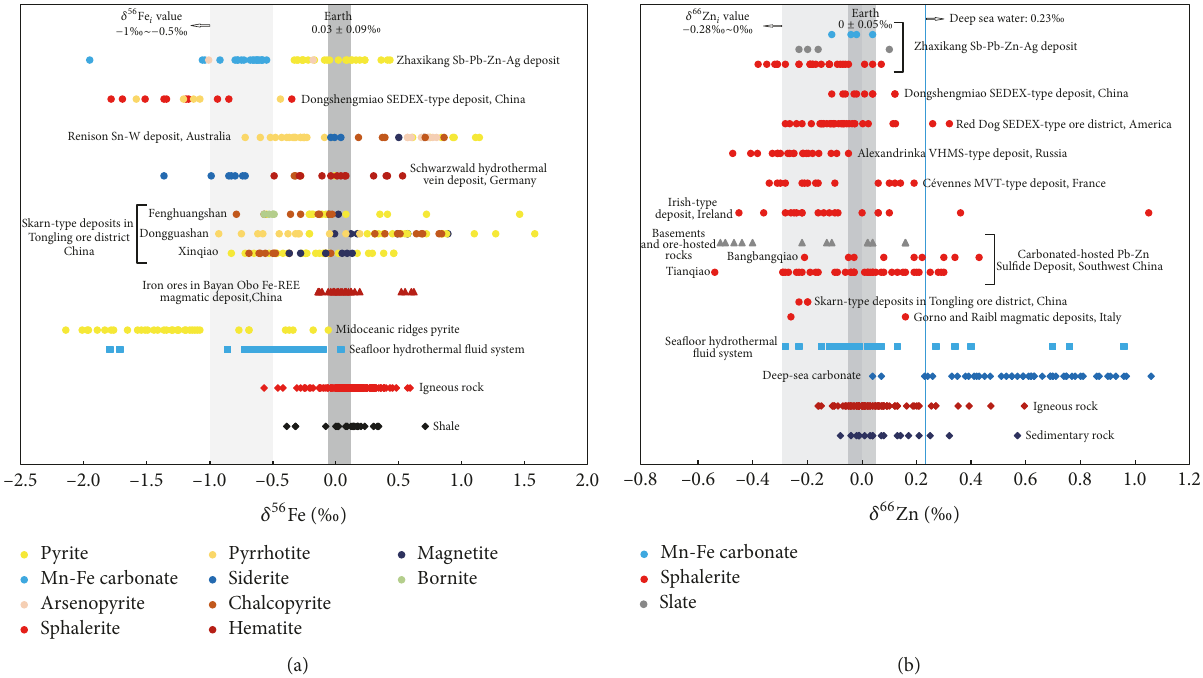
Figure 9: (a) Fe isotopic compositions of pyrite, Mn-Fe carbonate, and arsenopyrite in the Zhaxikang deposit (part of the data is quoted from Wang et al. [26]). Other Fe isotopic data for the Bulk Silicate Earth [10], shale [34, 35], igneous rocks [21–23, 28, 36–45], seafloor hydrothermal fluid system [34, 46–49], midoceanic ridges pyrite [48, 50], the Bayan Obo Fe-REE magmatic-type deposit in China [51], the